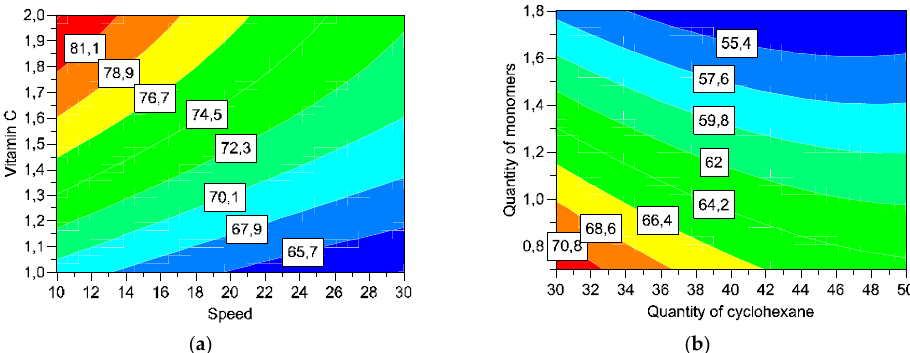
Figure 8. Response surfaces for encapsulation yield. by varying speed and vitamin C ( a ) and quantities of cyclohexane and monomers ( b ).